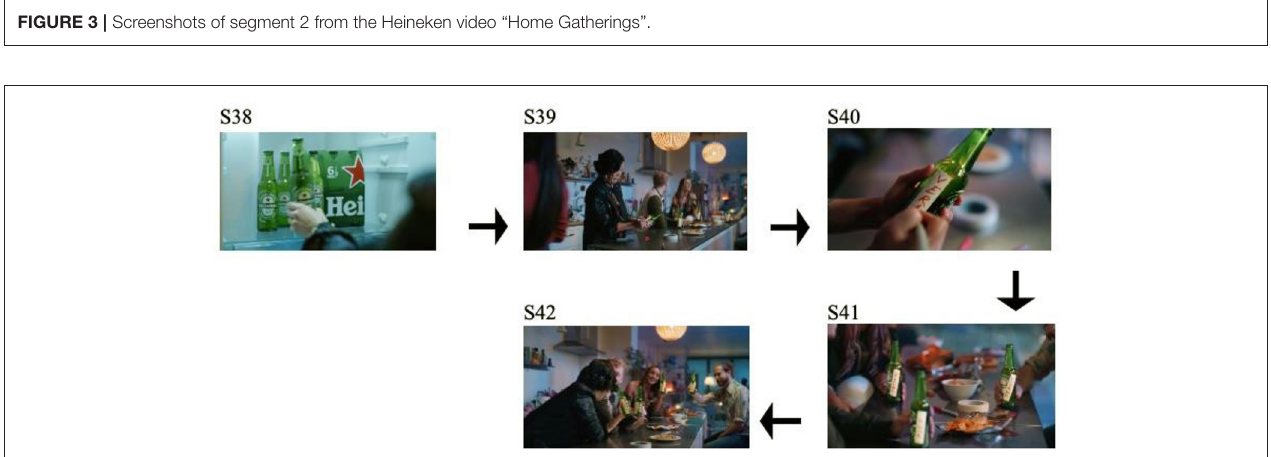
FIGURE 4 | Screenshots of segment 9 from the Heineken video “Home